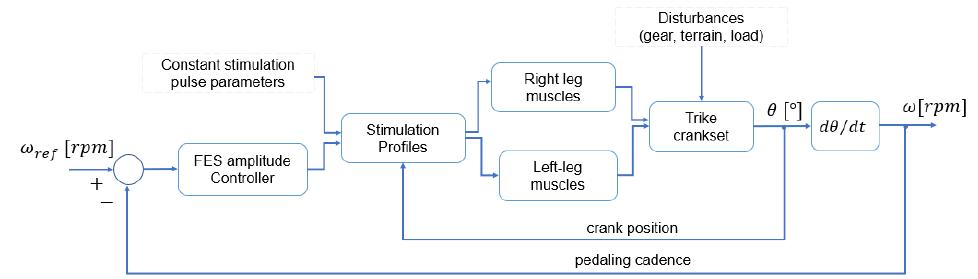
Figure 7. Final stimulation profiles showing the start and end angles for each muscle within a ped- aling cycle. Right and left hamstrings (HAM) are shown as the blue grids; right and left vastus me- dialis (VM) as the horizontal and vertical blue lines, respectively; and vastus lateralis and rectus femoris (VL + RF) as the dotted squares. Zero angle is when the crank arm is positioned horizontally, and the right leg extended.